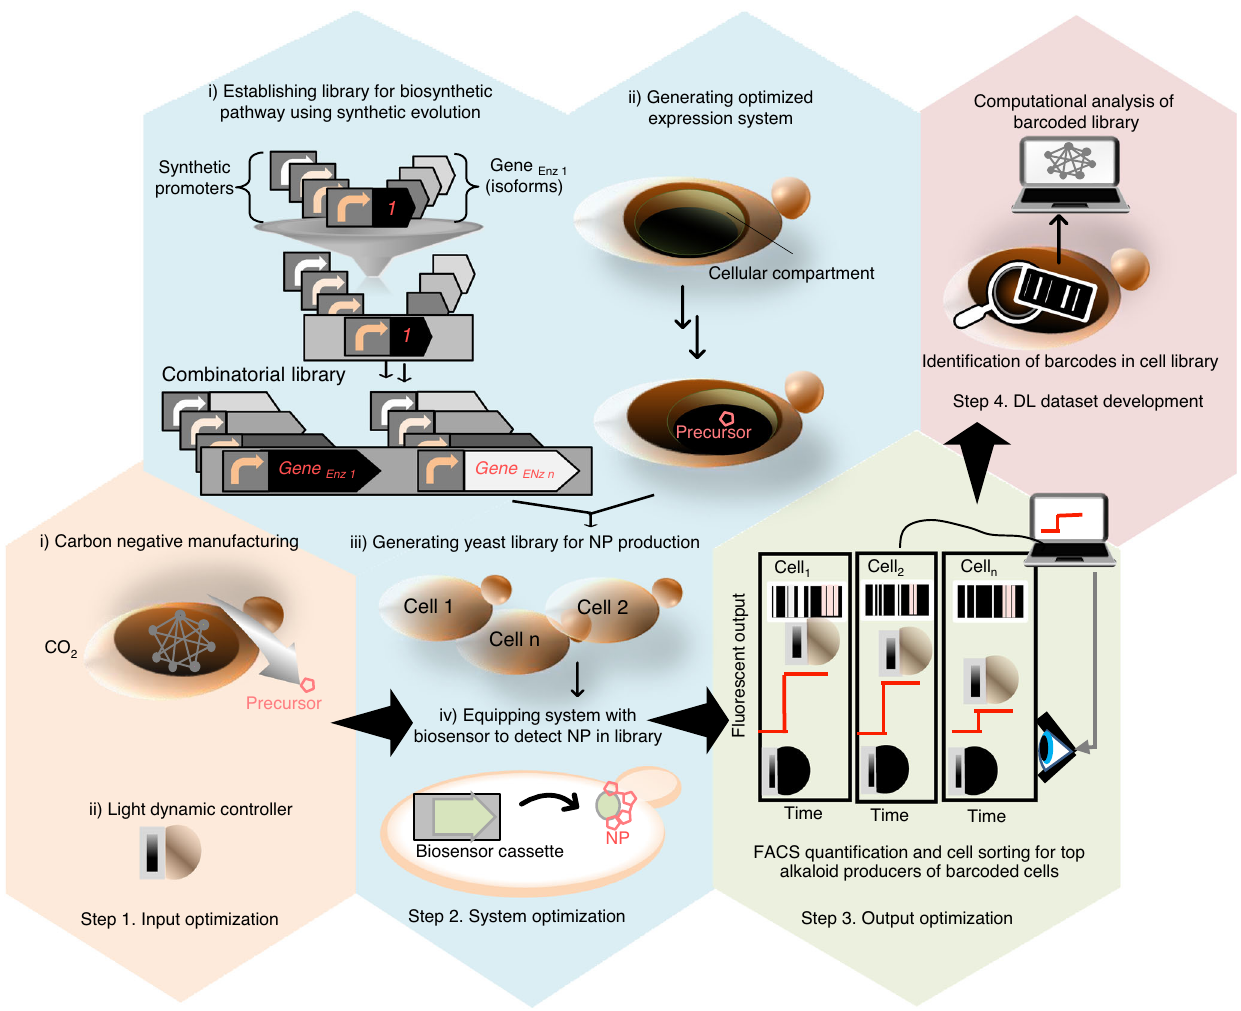
Fig.2|SchematicoverviewoftheplatformforsustainableproductionofNPsin yeast. To sustainably produce the highly required pharmaceutical NPs in